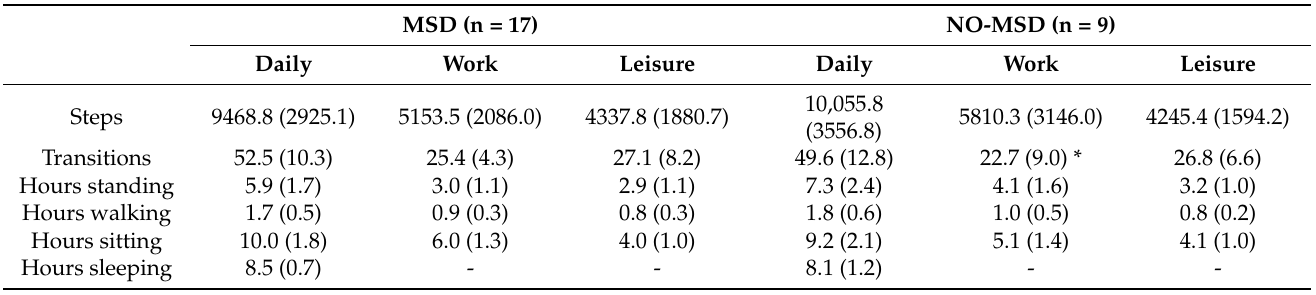
Table 3. Summary of the mean (SD) activity levels during work, leisure, and the entire day for the participants in the two groups.